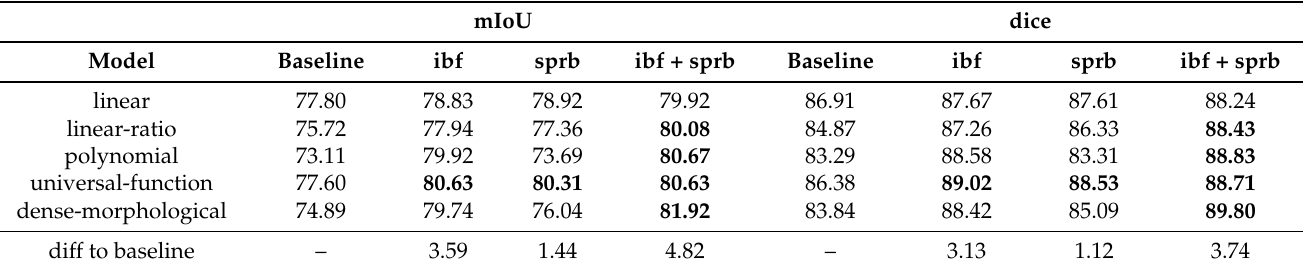
Table 5. Scores of DeepIndices with/without ibf and sprb for a kernel size of 5